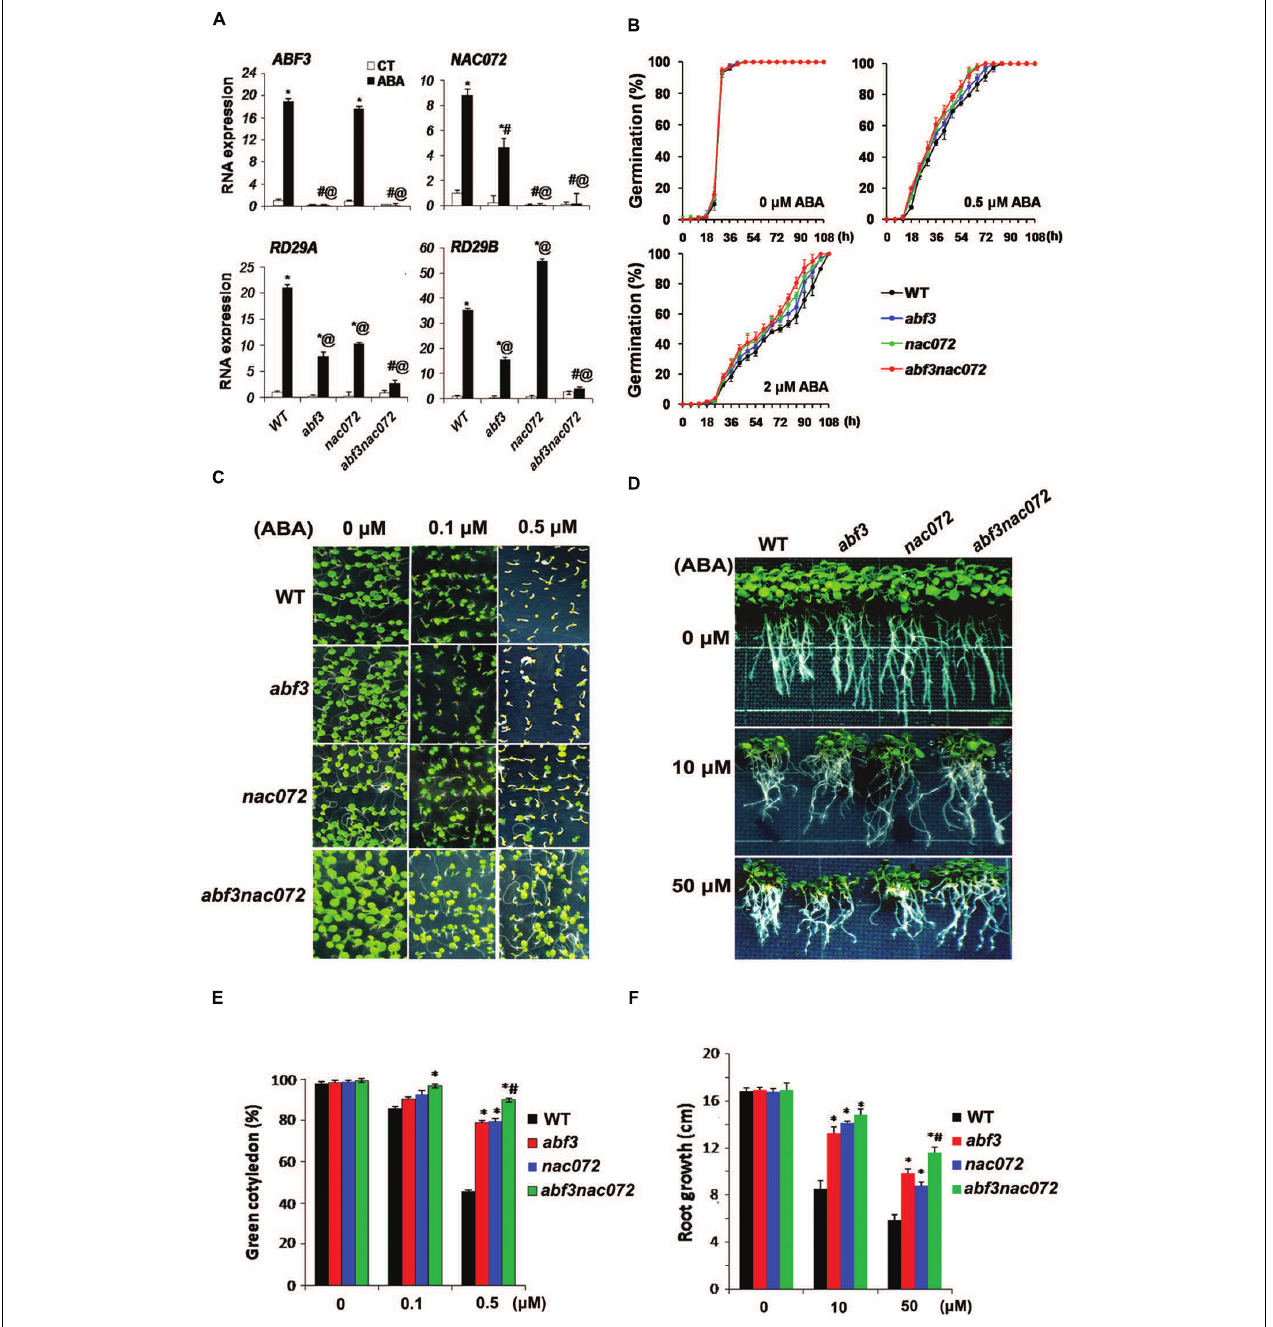
FIGURE 1 | The synergistic function of NAC072 in ABF3-mediated ABA response. (A) Gene expression of ABF3 , NAC072 , RD29A, and RD29B in mutant ( abf3 , nac072 , and abf3nac072 ) and wild type (WT) plants in response to ABA. The seedlings were grown on 0.5x MS agar plates for 12 days and then sprayed either with water (CT) or 100 µ M ABA (ABA) and assayed after 2 h. Bars indicate standard deviation, n = 3. ‘ ∗ ’ indicates a significant difference between CT and ABA treatments ( P < 0.05). ‘ # ’ indicates a significant difference between each mutant plants compared with WT plants under CT treatment ( P < 0.05). ‘@’ indicates a significant difference between each mutants plants compared with WT plants under ABA treatment ( P < 0.05). (B) Seed germination rate of mutant and WT in response to ABA. Germinations were recorded from 0 to 108 h after stratification on 0.5x MS agar plates containing 0, 0.5, or 2 µ M ABA. (C) Photographs of seedlings grown for 7 days after stratification on agar plates containing 0, 0.1, or 0.5 µ M ABA. (D) Photographs of seedlings grown for 20 days after transferral to control agar plates (0 µ M ABA) or plates containing 10 or 50 µ M ABA. (E) The statistical analysis of green cotyledons in (C) . Bars indicate standard deviation, n = 30. (F) The statistical analysis of axial root growth in (D) . Bars indicate standard deviation, n = 10. ‘ ∗ ’ indicates a significant difference between abf3 or nac072 plants compared with WT plants under the same ABA treatment ( P < 0.05). ‘ # ’ indicates a significant difference between abf3nac072 plants compared with abf3 or nac072 plants ( P <